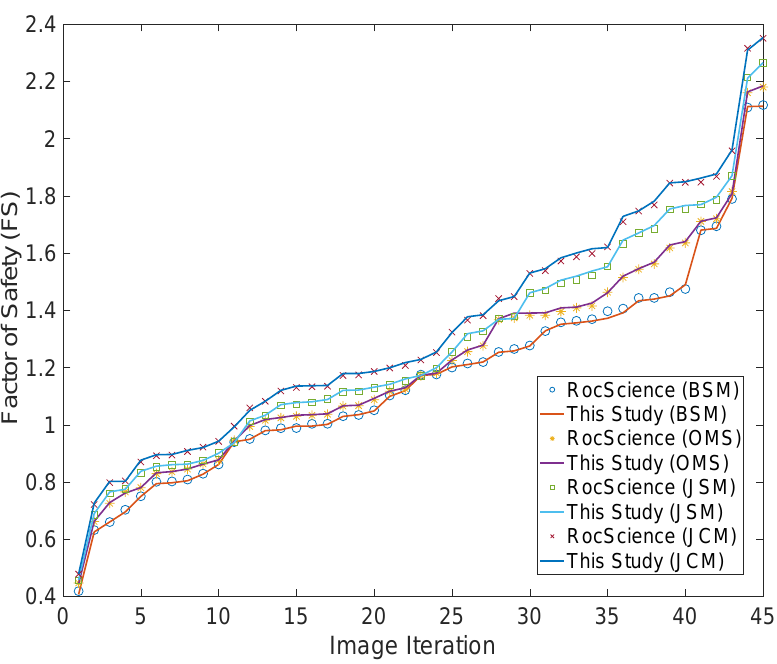
Figure 3. Comparison of FS s obtained with RocScience with the computer code.